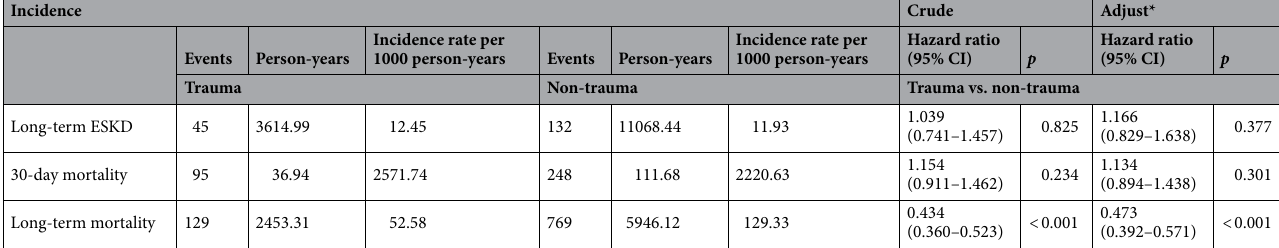
Table 2. Incidence and risks for outcome of interest in AKI patients with renal replacement therapy during hospitalization, between vehicle-traumatic patients and their matches. ESKD, end-stage kidney disease; CI, confidence interval. *The multivariable Cox regression model selected covariates from all variables in Table 1 and cardiogenic shock and exposure to nephrotoxic medications by a stepwise